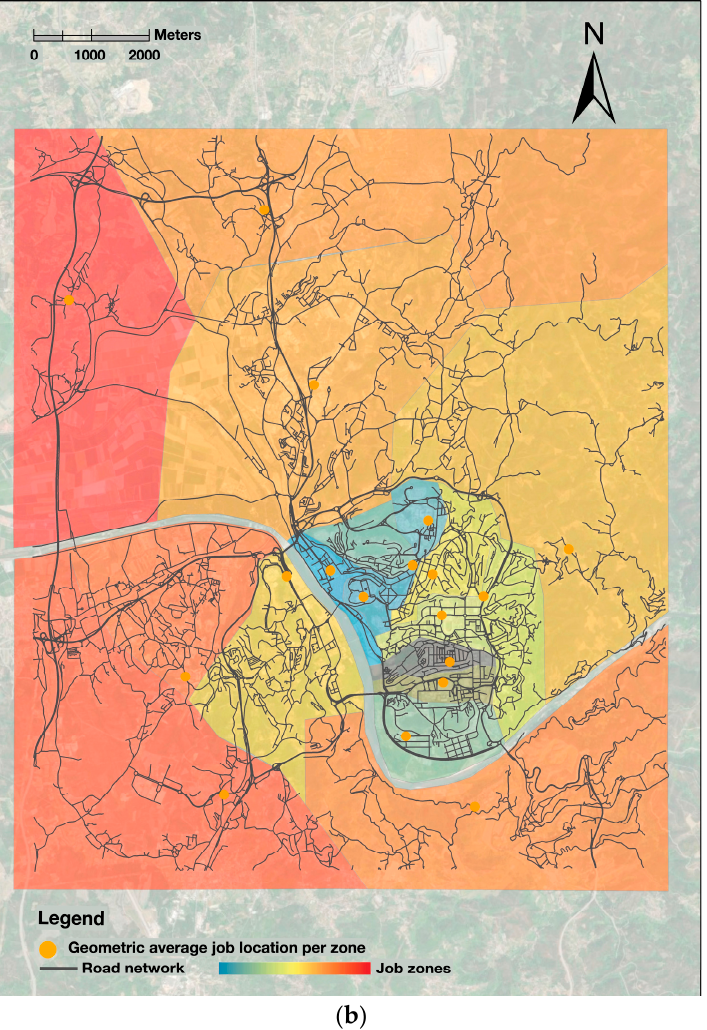
Figure 2. ( a ) Coimbra origins, urban facilities, and road network; ( b ) Coimbra job zones and main job locations.